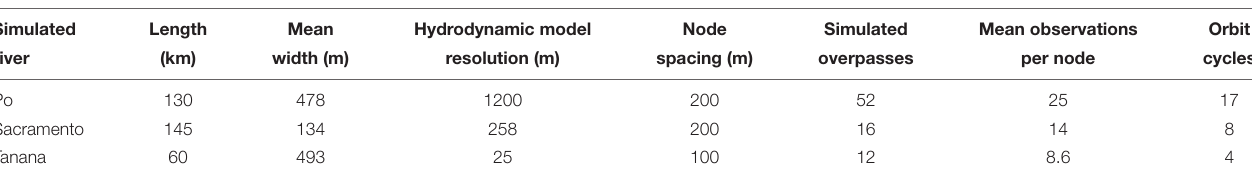
TABLE 1 | Physical and SWOT simulation characteristics of the sample rivers. Simulated Length Mean Hydrodynamic model Node Simulated Mean observations Orbit spacing (m)